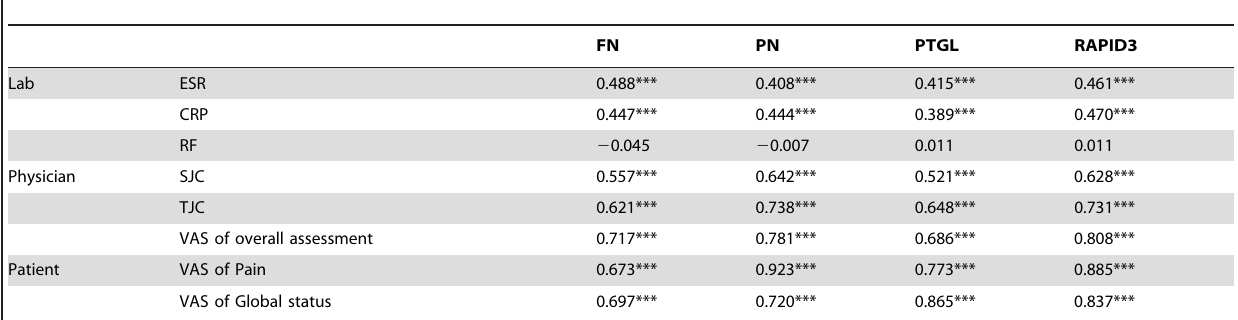
Table 5. Correlations of RAPID3 and components with disease